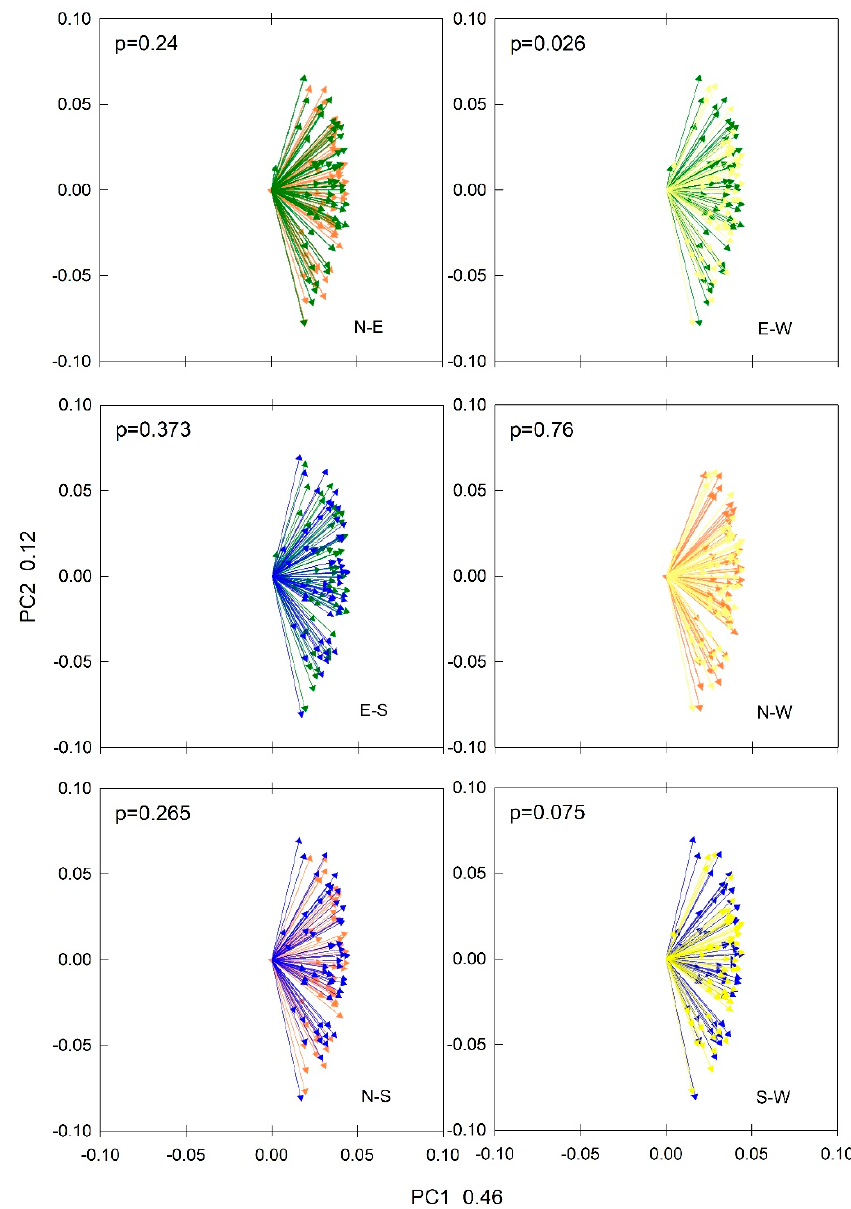
Figure 3. Directional differences in growth variability according to PCGA. p: p -value of Wilcoxon signed-rank tests. Orange arrows refer to northern, green arrows to eastern, yellow arrows to western, blue arrows to south. PC1 is the first principal component and PC2 is the second principal component.